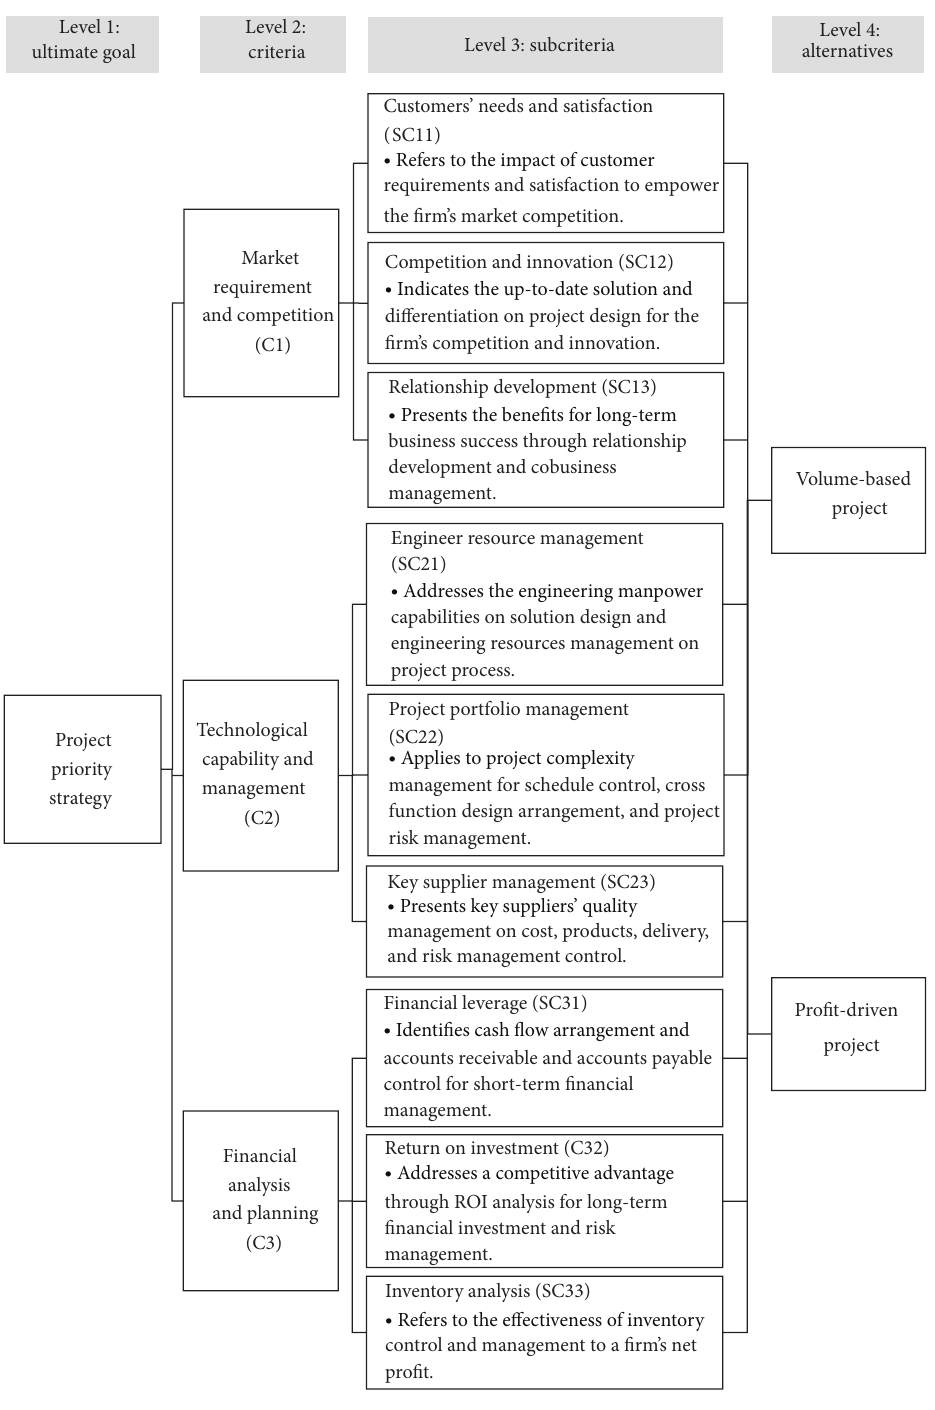
Figure 3: The hierarchical structure for a project priority